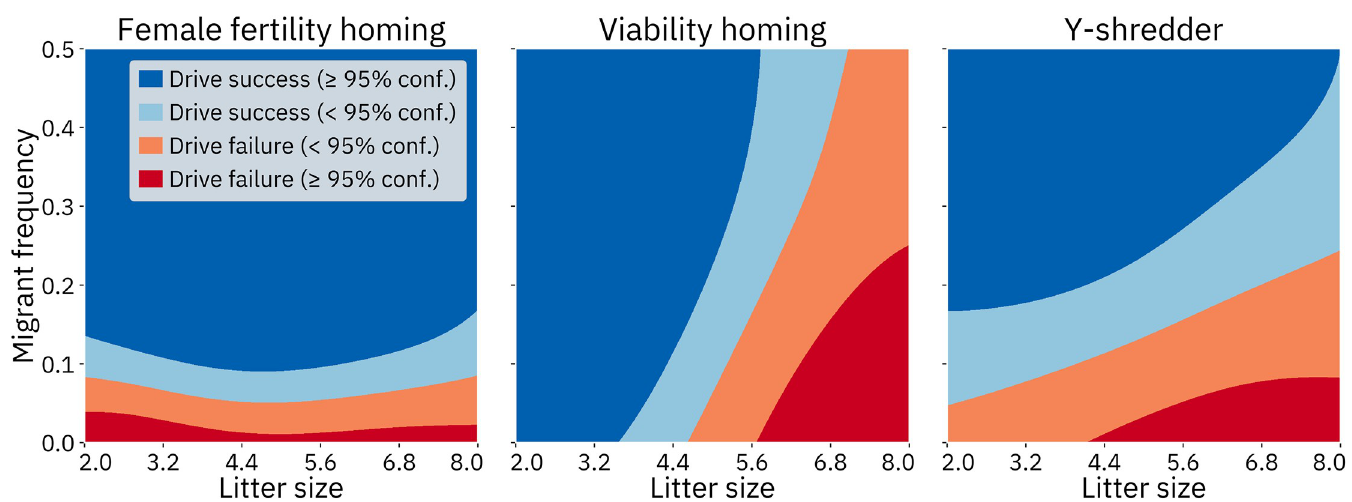
Fig 11. Comparison of the three drives with varying litter size and migrant frequency. For the female fertility homing drive, fitness and efficiency were both fixed at 90%. For the viability homing drive, fitness and efficiency were both fixed at 97%. For the Y-shredder, fitness and efficiency were both fixed at 99%. The models without resistance were used.